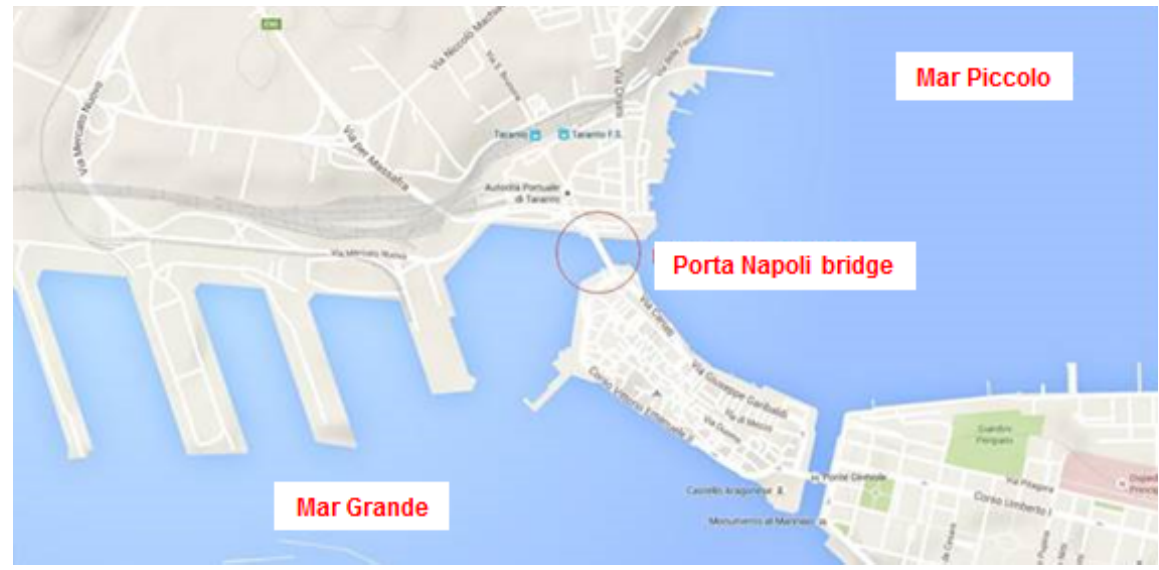
Figure 1: Taranto: Overview with Porta Napoli bridge location.